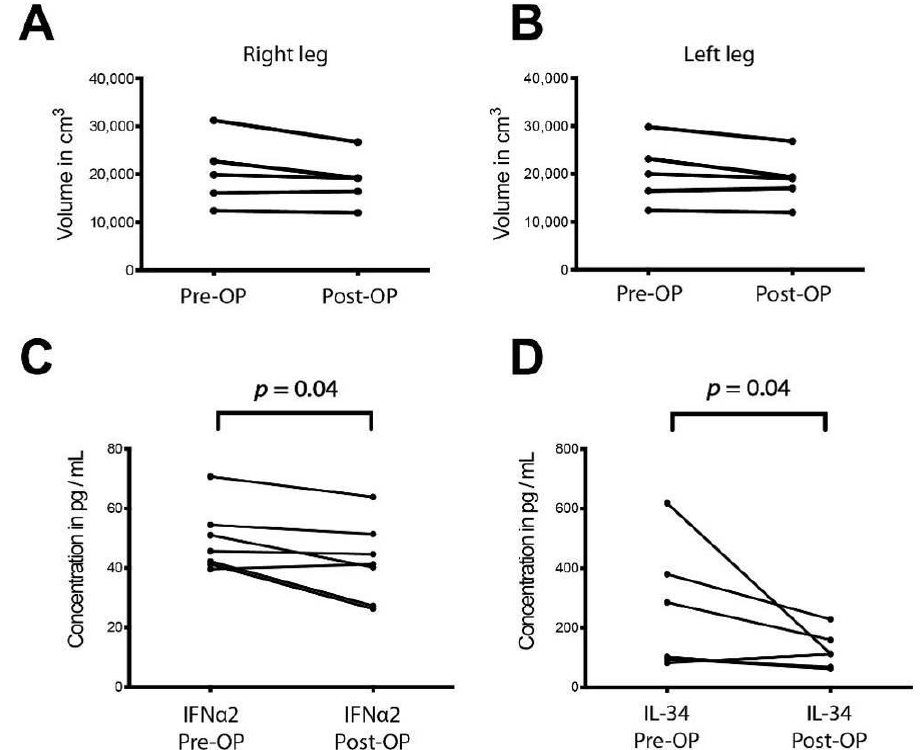
Figure 5. Inflammatory cytokine and chemokine profile in the serum of lipedema patients pre- and one year post- operatively ( A , B ) Analysis of the limb volume pre- and one year post-operatively observed no significant volumetric changes. N: 5 patients ( C , D ) Serum was examined pre-operatively and one year post-operatively using Multiplex. Out of 22 cytokines detected, interferon alpha ( IFNα ) and interleukin 34 (IL34) blood concentrations were decreased one year post-operatively. N: 7 patients. The p- values indicate the statistical significance in comparison to the control (two-tailed paired Student t-test).